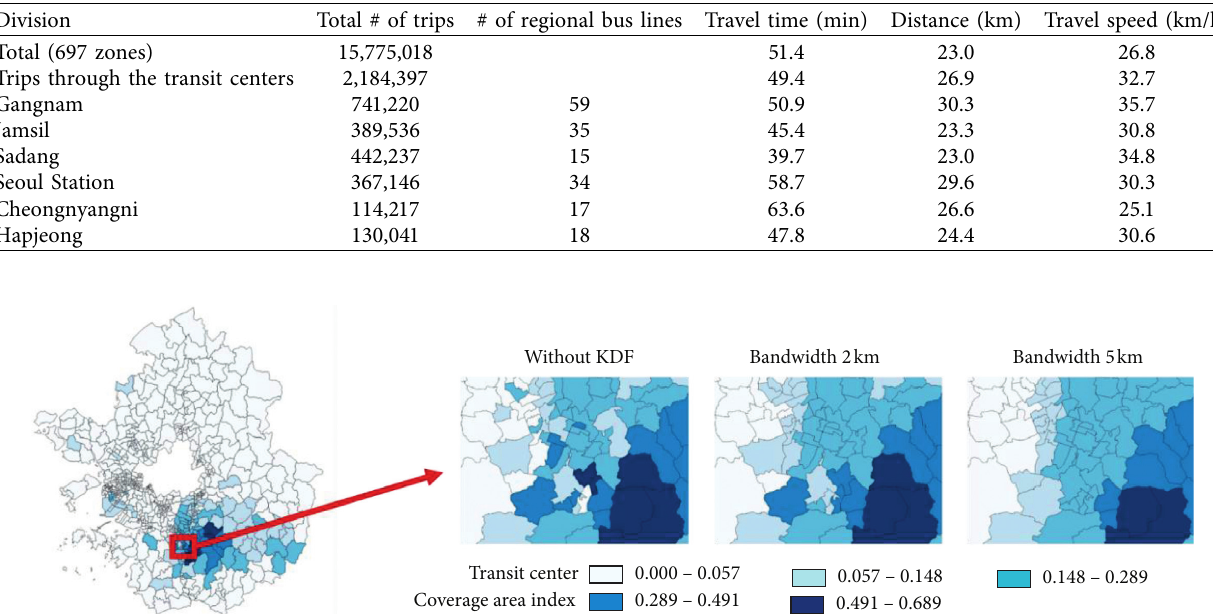
Figure 3: Effect of kernel bandwidth to CAI of Gangnam in the southern part of the Seoul suburban